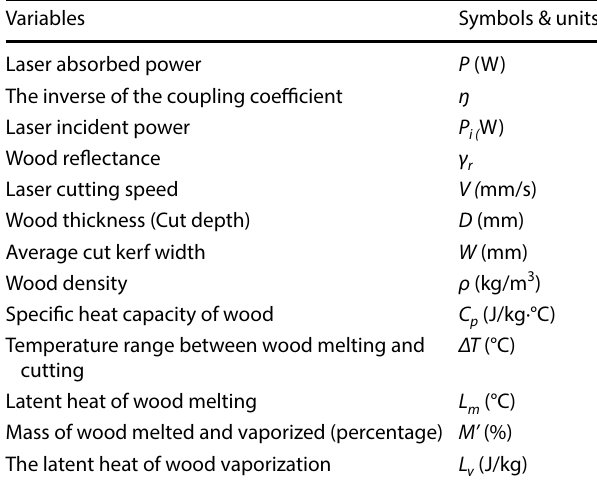
Table 1 Variables designation in Eq. (1) Variables Symbols &